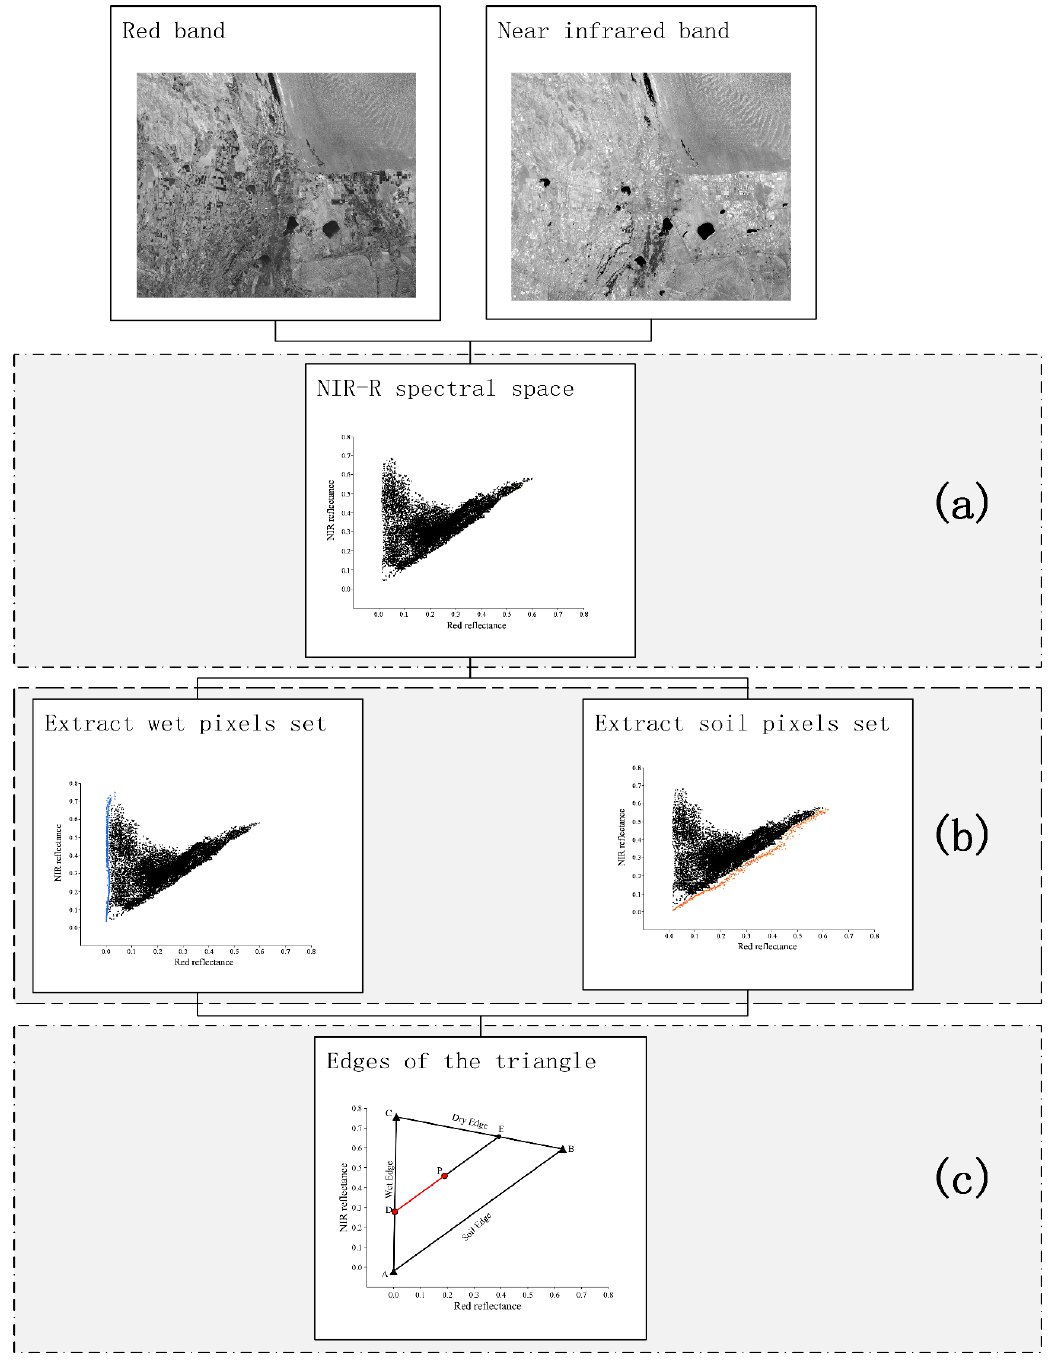
Figure 9. Flowchart for calculating the RDMI. ( a ) Establishment of the NIR–Red spectral space, ( b ) extracting the triangle boundary point set, and ( c ) the triangle boundary fit according to the point set, and calculation of the RDMI.